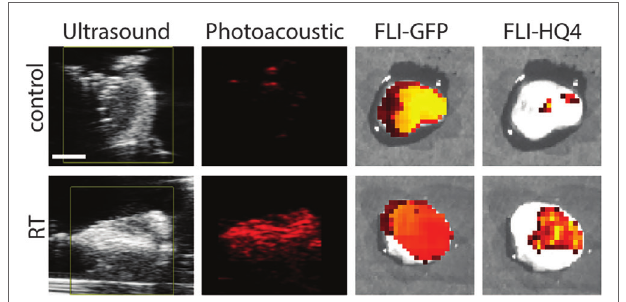
FigUre 5 | Ex vivo photoacoustic and fluorescence imaging . Representative ultrasound, photoacoustic, GFP fluorescence (FLI-GFP) and